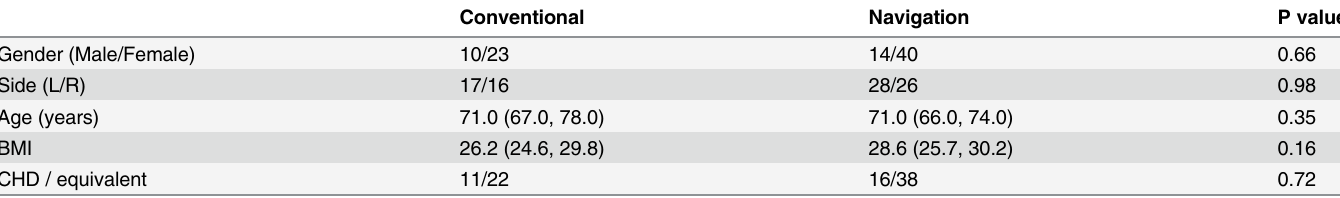
Table 1. Baseline clinical and radiographic characteristics of patients undergoing conventional or navigation TKA